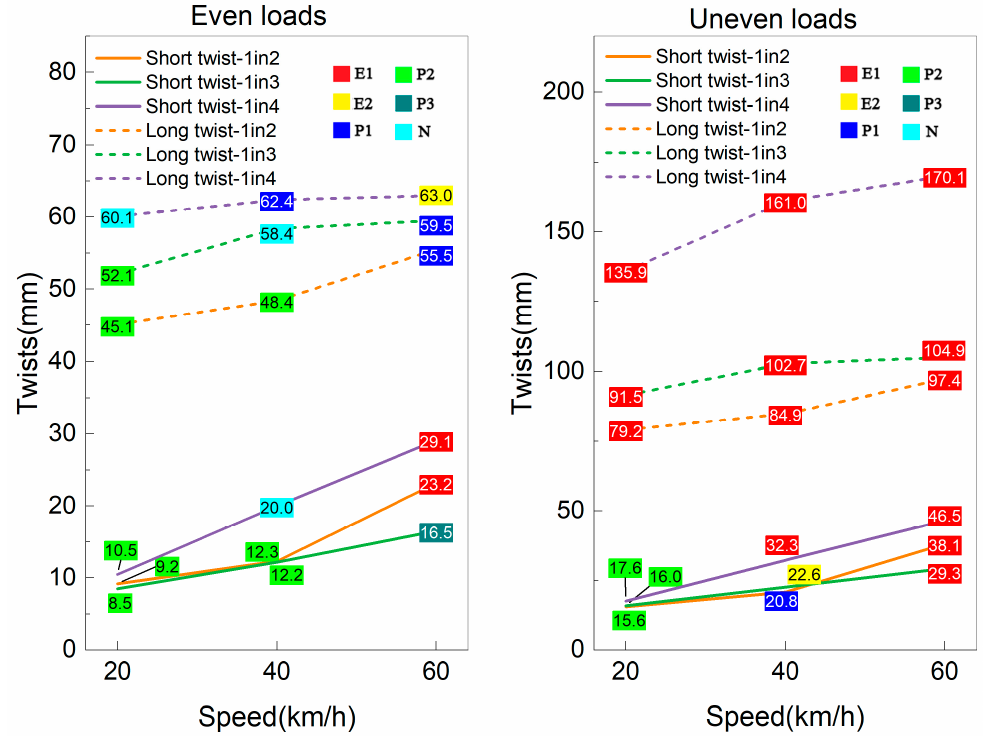
Figure 14. Dynamic twists of 1in2, 1in3 and 1in4 interspersed tracks under large-scale loss support and different load conditions.